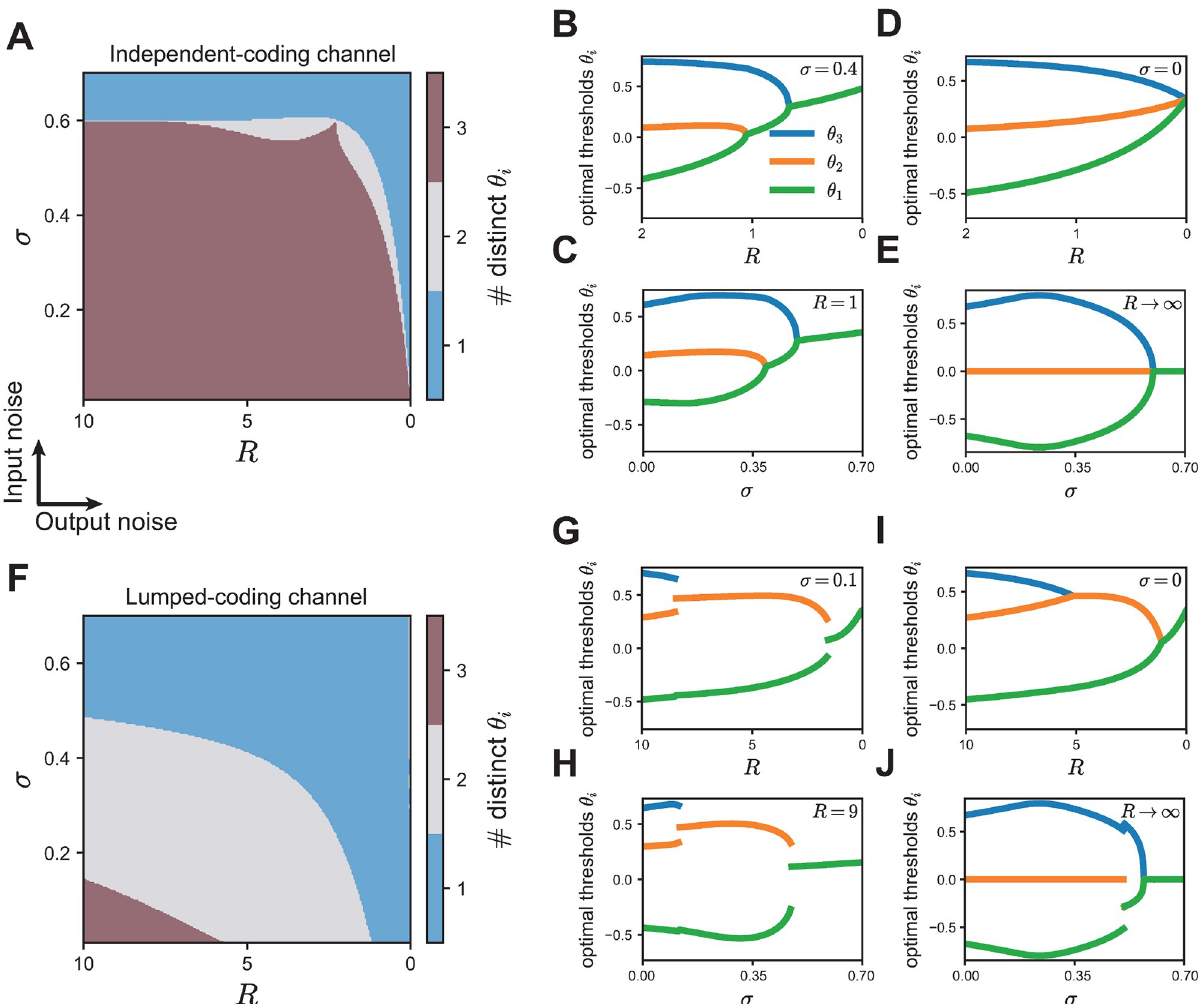
Fig 4. Optimal thresholds for the independent- and lumped-coding channels. Optimal thresholds for the independent-coding channel (A-E) compared to the lumped-coding channel (F-J) for a population of three neurons. A . The optimal number of distinct thresholds depends on input noise σ and output noise R . B . The optimal thresholds as a function of output noise for a fixed value of input noise ( σ = 0.4). C . The optimal thresholds as a function of input noise for a fixed value of output noise ( R = 1). D . The optimal thresholds as a function of output noise in the limit of no input noise ( σ = 0). E . The optimal thresholds as a function of input noise in the limit of vanishing output noise ( R ! 1 ). F-J . As (A-E) but for the lumped-coding channel. Intermediate noise levels where bifurcations occur in (G,H) take smaller values of R and σ in the lumped- that in the independent-coding channel since lumping itself acts like a source of noise (G: σ = 0.1, H: R =